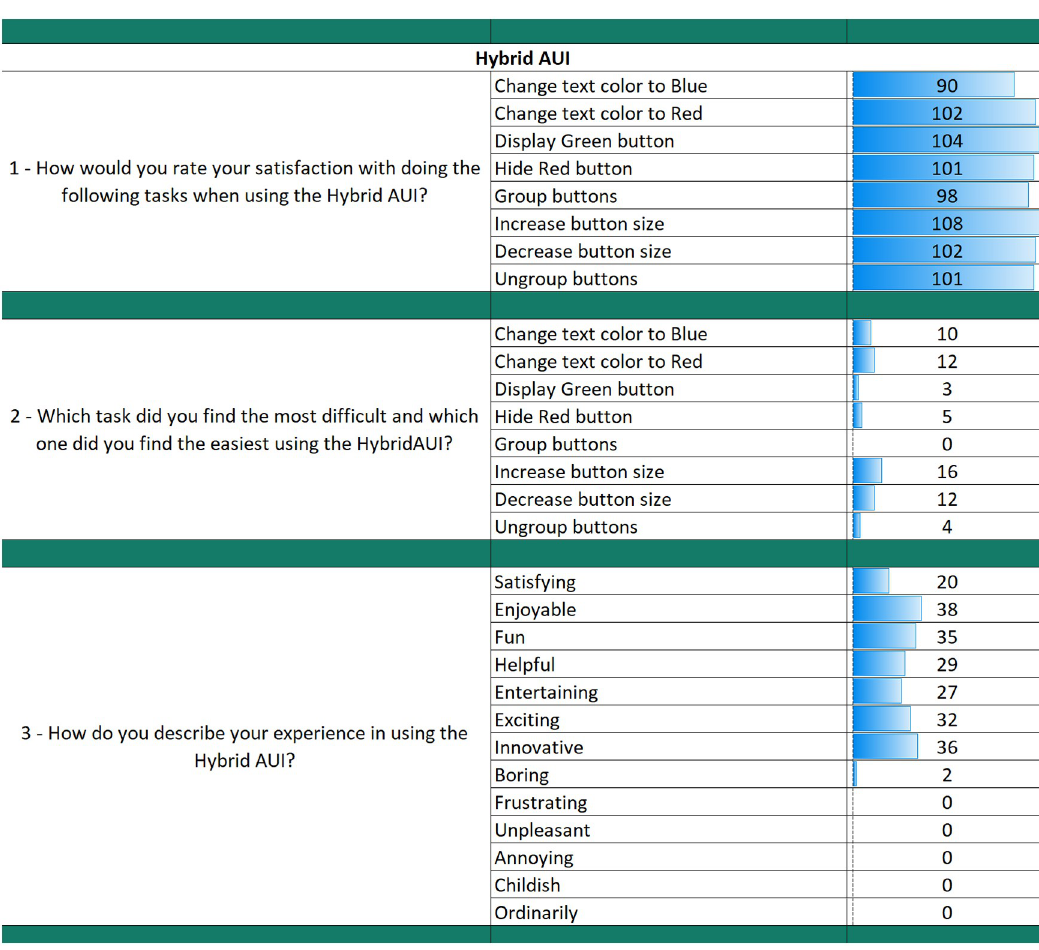
Fig 20. Questionnaire results for the Hybrid